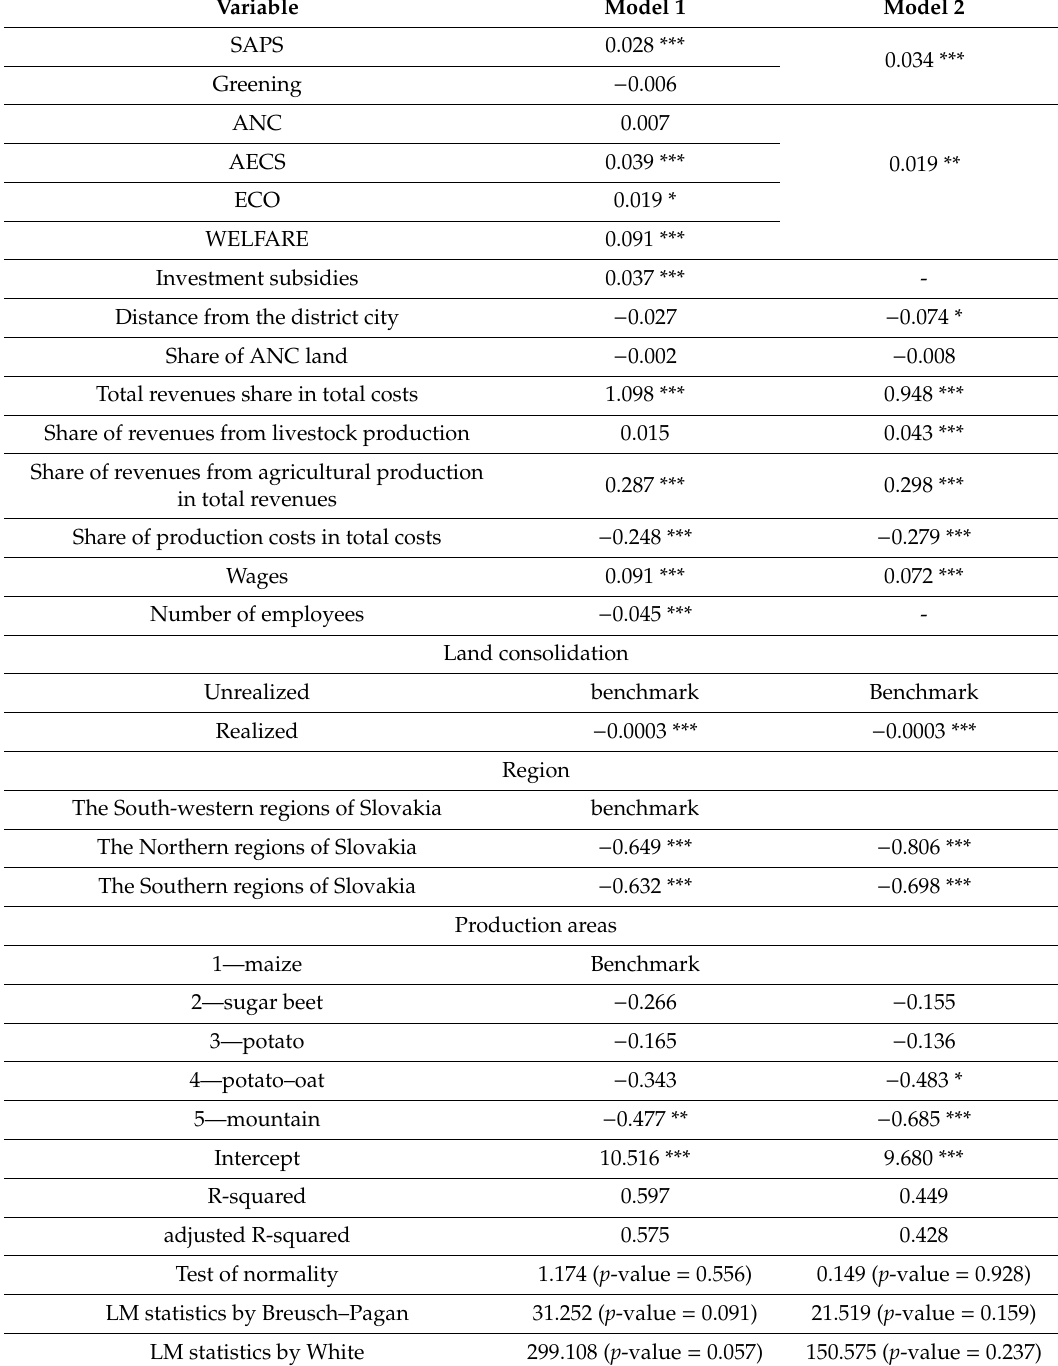
Table 2. Econometric models with dependent variable of land rental